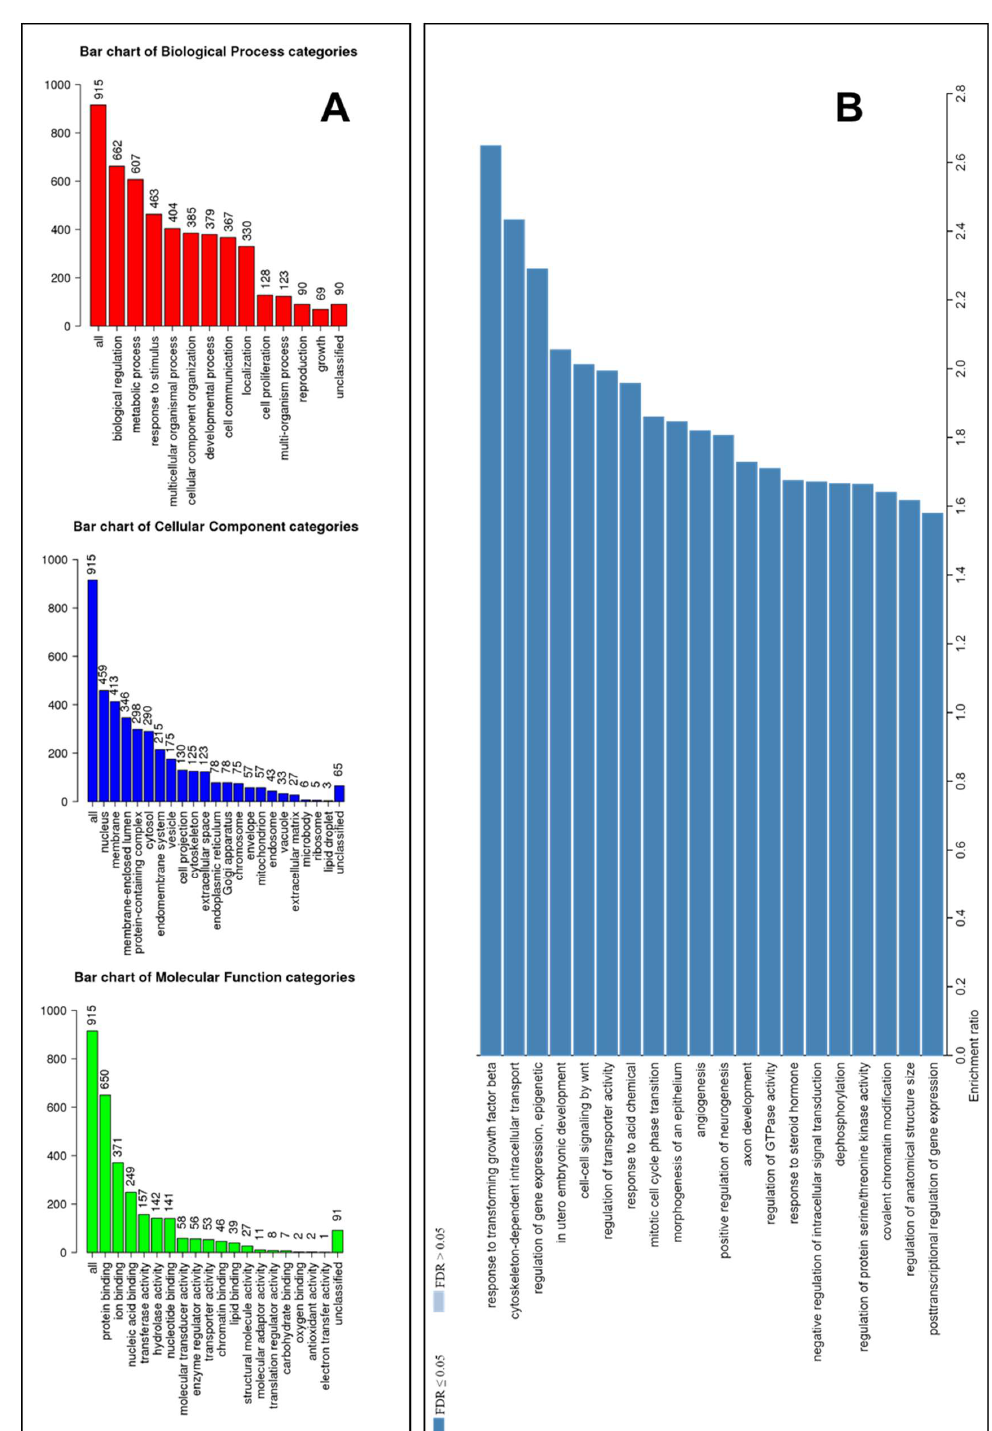
Figure 4. An enrichment analysis by the WEB-based Gene SeT AnaLysis Toolkit (WebGestalt) and main gene ontology (GO) annotations of the biological process category. ( A ) A GO Slim summary